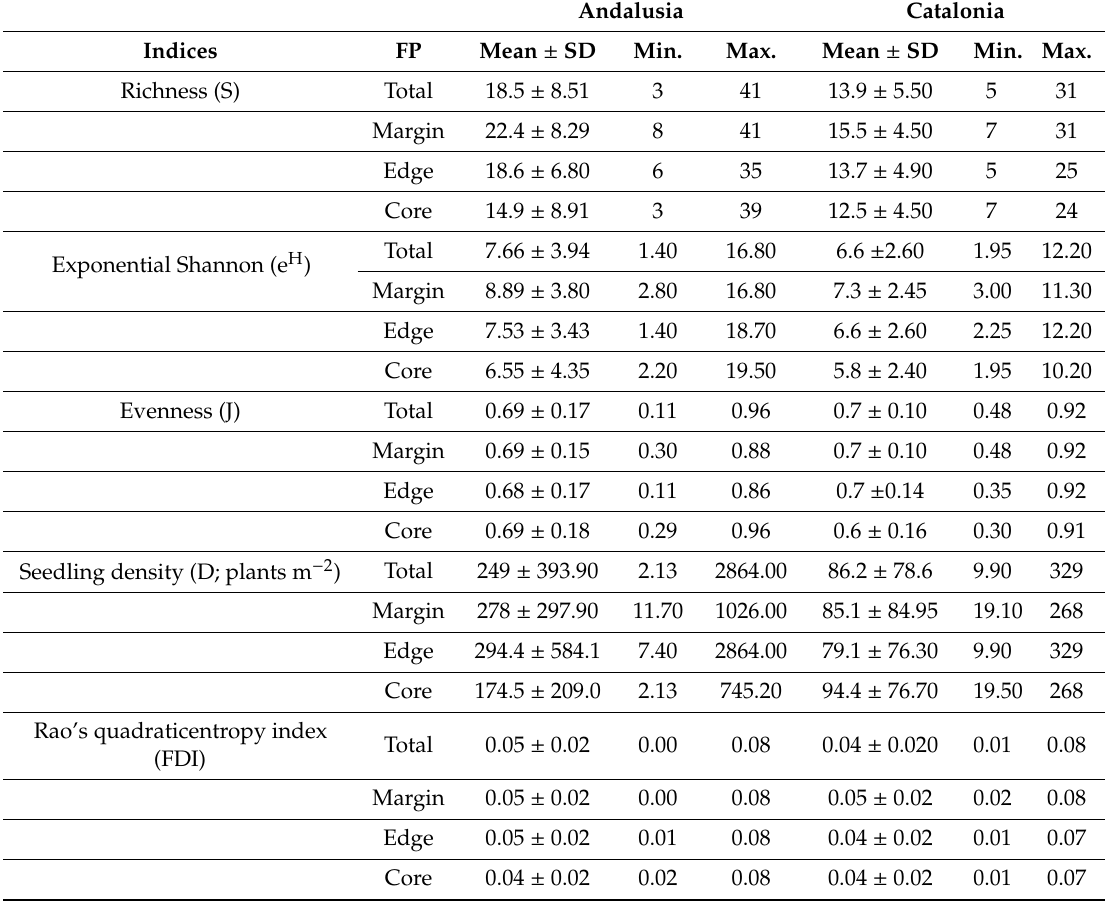
Table 3. Mean ± standard deviation (SD) and minimum and maximum values of species richness, exponential Shannon, evenness, and Rao’s quadratic entropy index of the seed bank of Andalusia and Catalonia, respectively. Taxonomic indices were computed, taking into account all the recorded species, whereas Rao’s index was computed for the 77 and 62 species recorded at a frequency of ≥ 5% in Andalusia and Catalonia, respectively. Field Position